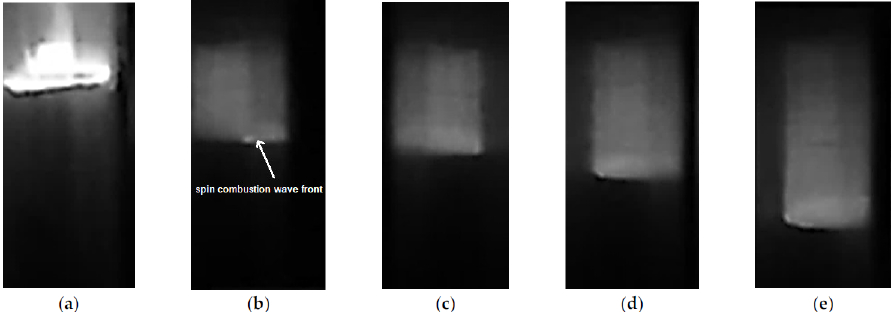
Figure 2. Images of spin combustion in the samples of the NiB-Ti mixture: ( a ) combustion initiation, ( b ) 20 s, ( c ) 23 s, ( d ) 37 s and ( e ) 51 s.